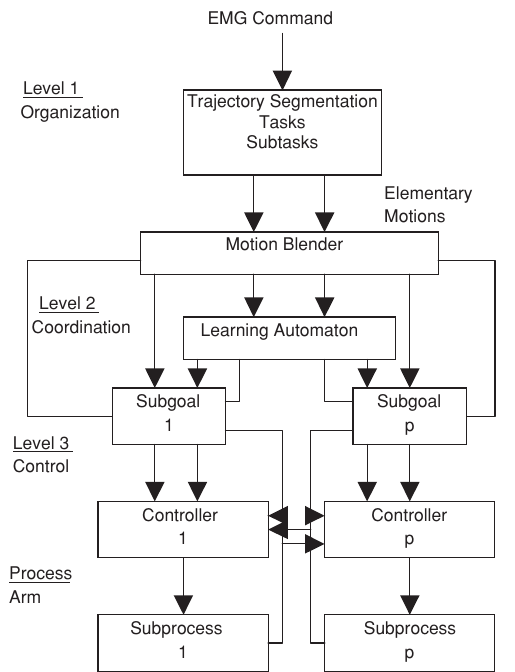
Figure 6 Hierarchically intelligent control of a prosthetic